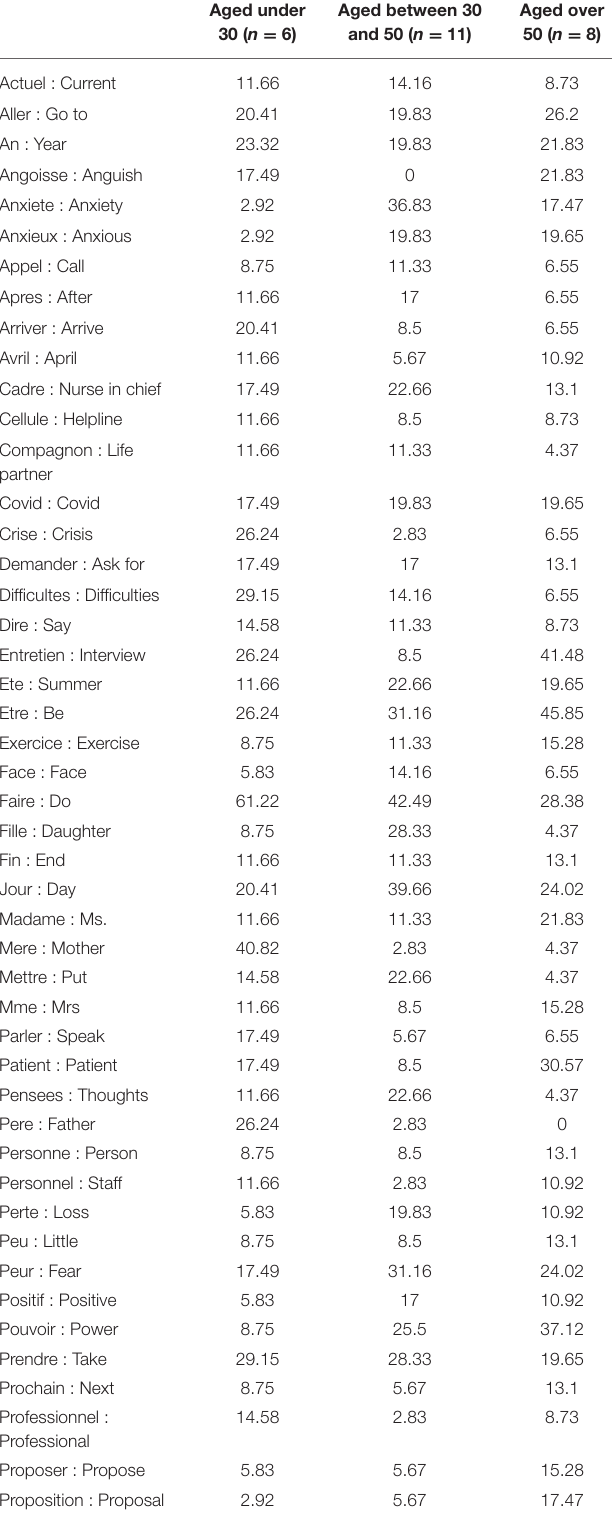
Aged under Aged between 30 30 ( n = 6) and 50 ( n = 11)